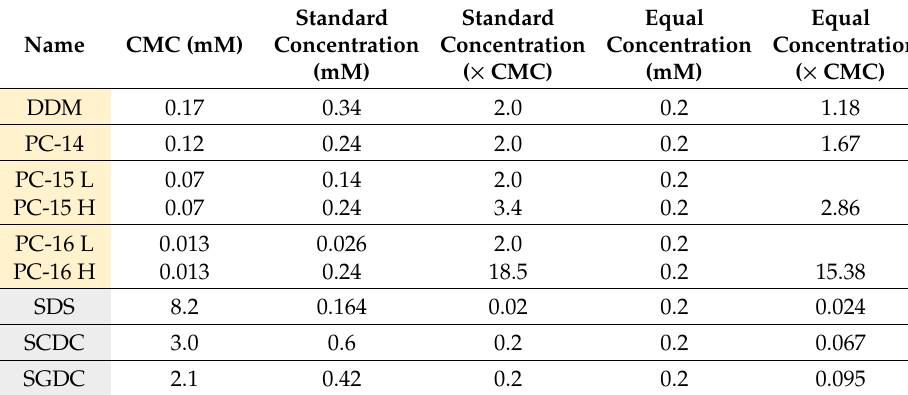
Table 1. Interconversion between × CMC and mM for the standard detergent concentrations and the equal detergent concentrations used. Detergents where concentrations were always above or below their CMC are marked in yellow and grey, respectively. For SDS the concentration increases when going from the standard (0.02 × CMC) concentration used to 0.2 mM while for all other detergents here the concentration